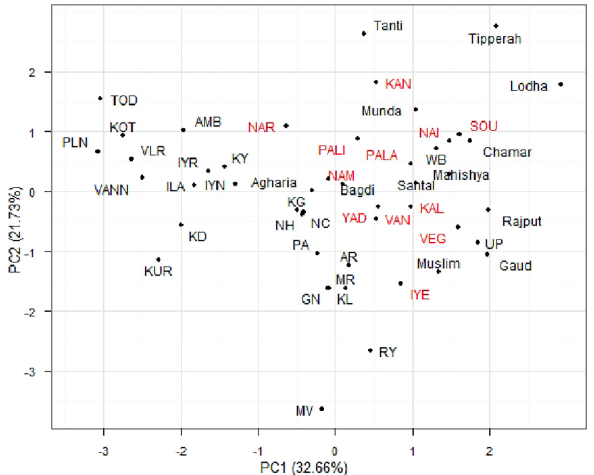
Fig 5. Principal component analysis of 48 caste populations of India based on allele frequency data (Red color indicates present study populations).